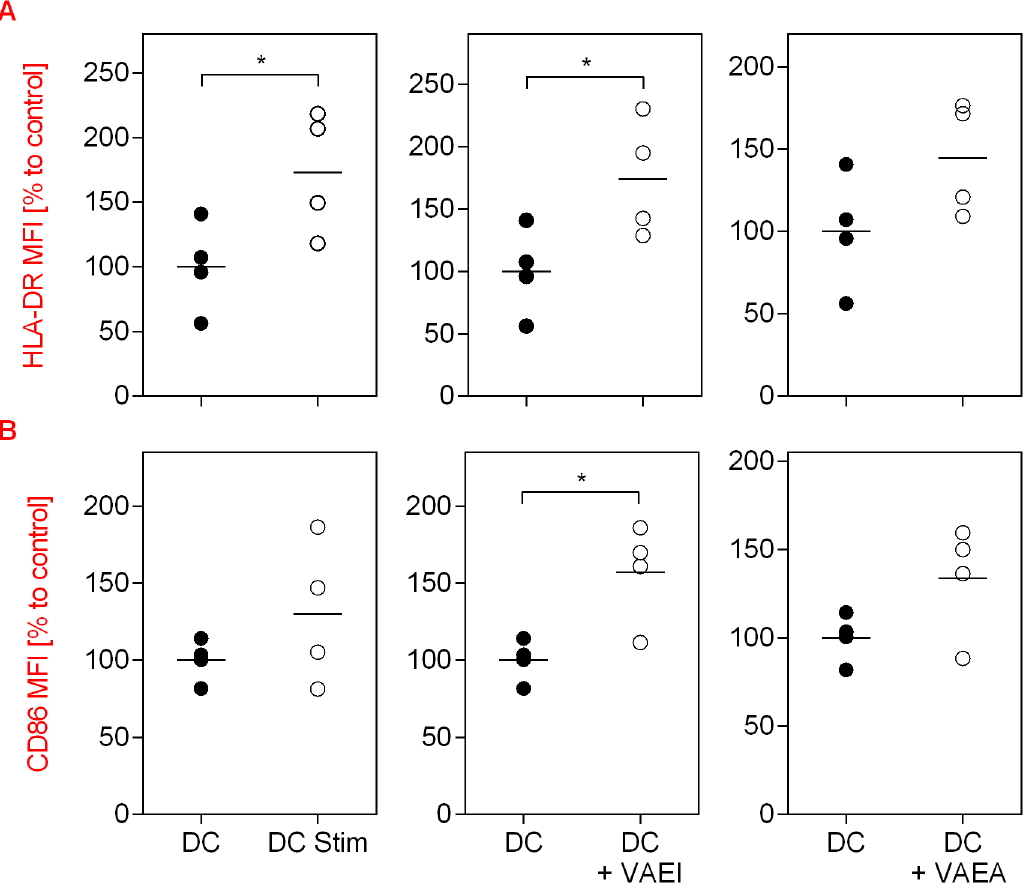
Fig 3. CD86 and HLA-DR expression measuredby confocal microscopy. CD14 + monocyteswere matured to immature DC and incubatedwith medium (DC), maturation cocktail (DC Stim; 500 ng/mL LPS; 50 ng/mL TNF-alphaand 10 ng/mL IL-1beta), VAEI (DC + VAEI; Iscador ® Qu Spez; 0.5 μ g/ml) or VAEA (DC + VAEA; abnobaVISCUM ® Fraxini; 0.06 μ g/ml). After cultivationautomatedfluorescence microscopyand analysisof HLA-DR (A) and CD86 (B) expression was carried out. High HLA-DR and CD86levels indicateDC maturation. MFI = Mean fluorescence intensity. Data and mean of 4 individual experiments are presentedin relationto untreatedcells (DC = 100%). Asterisks indicate